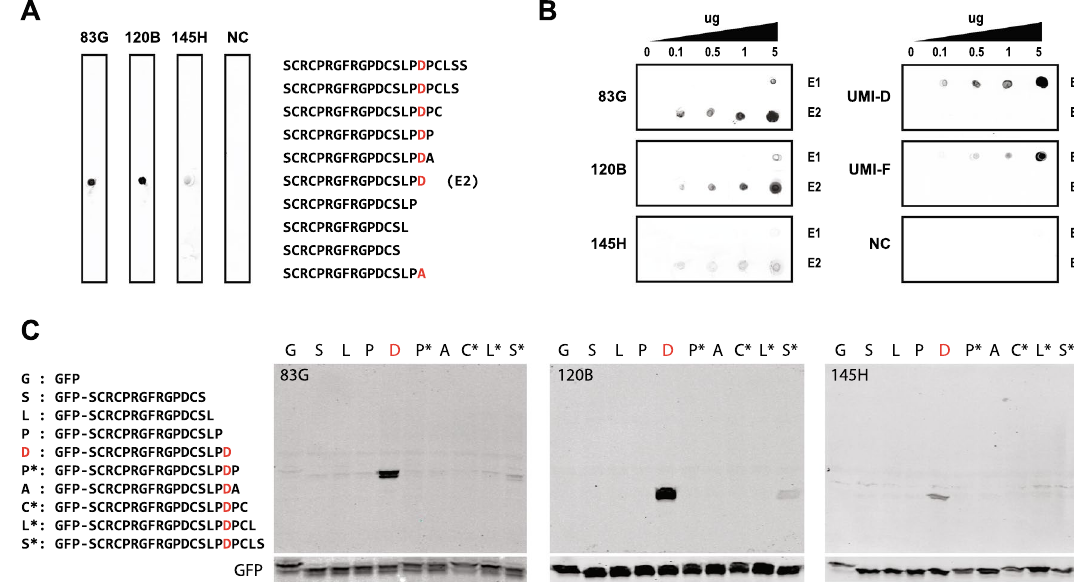
Figure 2. Monoclonal antibodies to a neo-epitope produced by cleavage between the second and third EGF- like domains of NOTCH3. Monospecific reagents were selected based on binding to the neo-epitope ending in Asp121. ( A ) The specificity of three antibodies used in this study were characterized by probing dot blots of peptides with the sequences shown. NC was a negative control sample containing irrelevant rabbit antibody. The terminal residue of the neo-epitope revealed by cleavage after Asp121 is shown in red. The peptide used for immunization is denoted E2. The peptide at the bottom includes a mutation of Asp121 to alanine